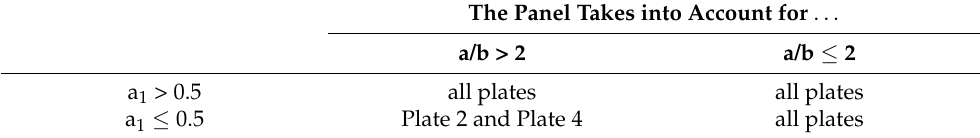
Table 2. The requirements [2] on the need to take into account the panel as a part of the plate (see Figure 5). The Panel Takes into Account for . .